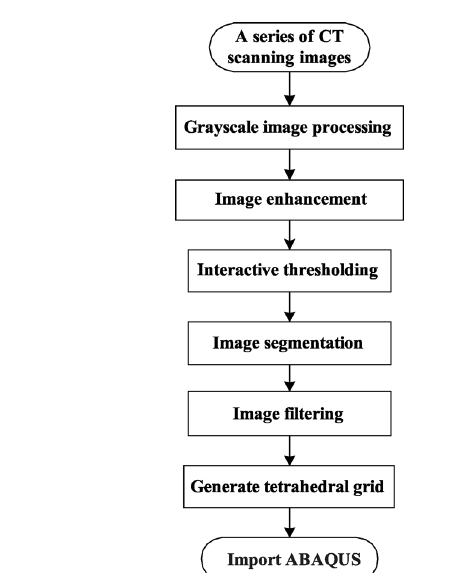
Fig. 3 Processing workflow of the X- ray μCT images by using the Avizo